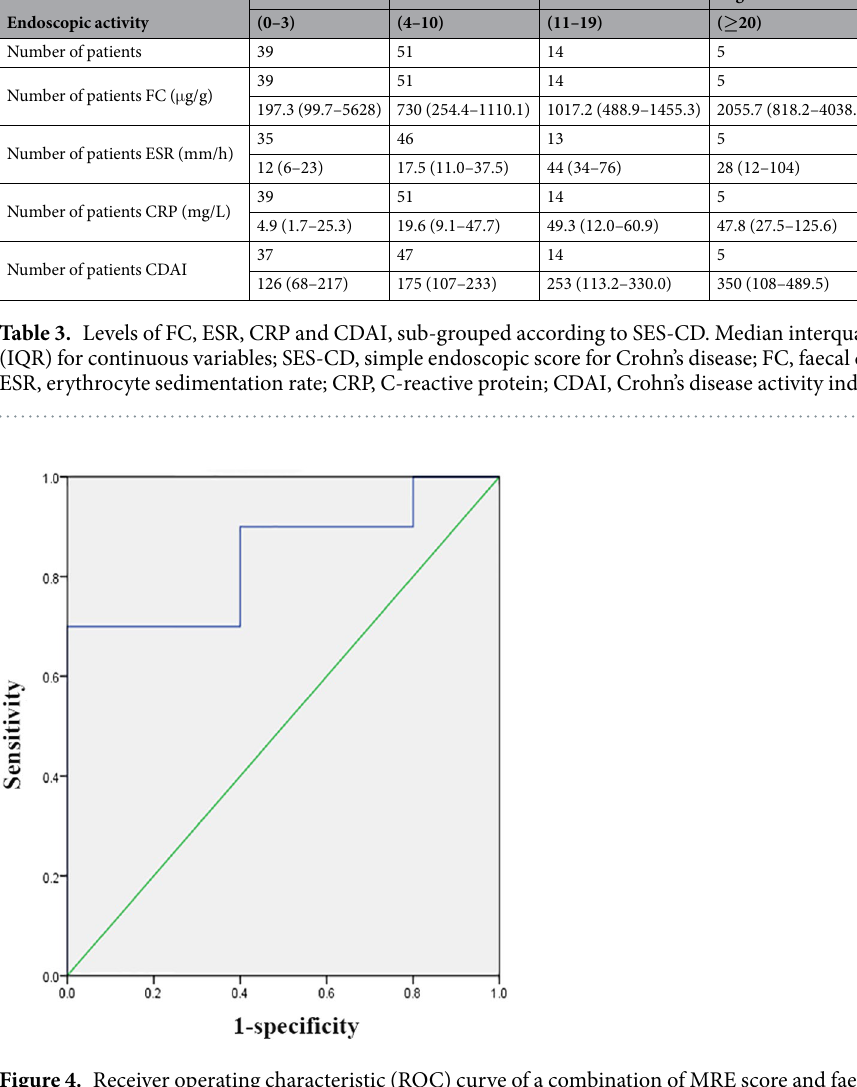
Figure 4. Receiver operating characteristic (ROC) curve of a combination of MRE score and faecal calprotectin and erythrocyte sedimentation rate and C-reactive protein and Crohn’s disease activity index in predicting endoscopic mucosal healing. The area under the curve was 0.840 (95% CI: